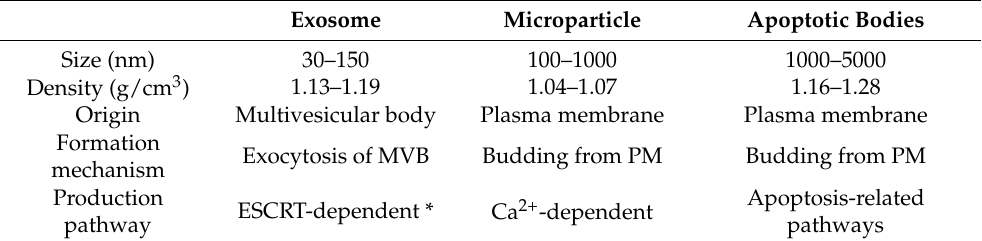
Table 1. Main characteristics of exosomes, microparticles, and apoptotic